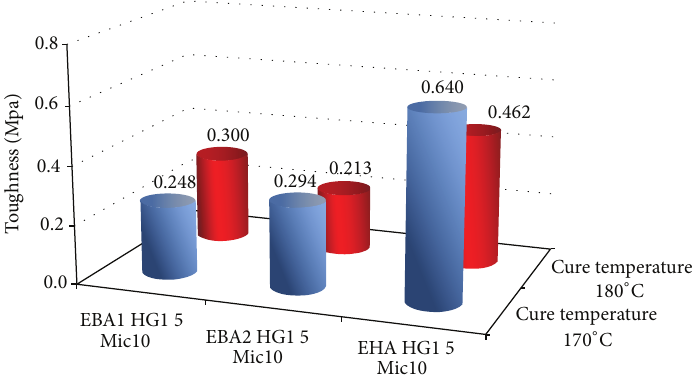
Figure 6: Toughness of self-healing systems with different epoxy matrices at different curing temperature of 170 ∘ C and 180 ∘ C.